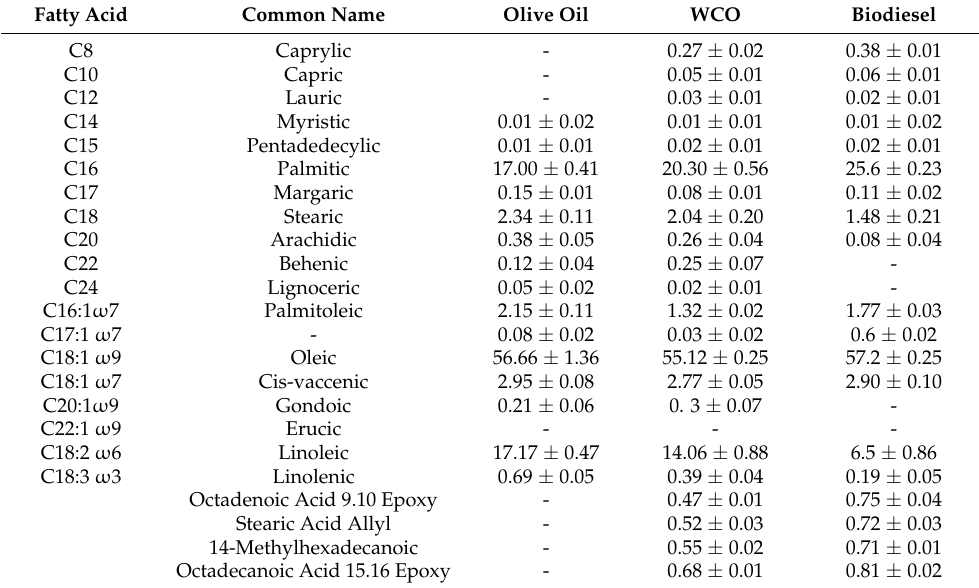
Table 3. Fatty acid compositions (%) of olive oil from Sigma Aldrich, waste cooking oil (WCO), and produced biodiesel with of 1% of immobilized lipase mixture concentration.